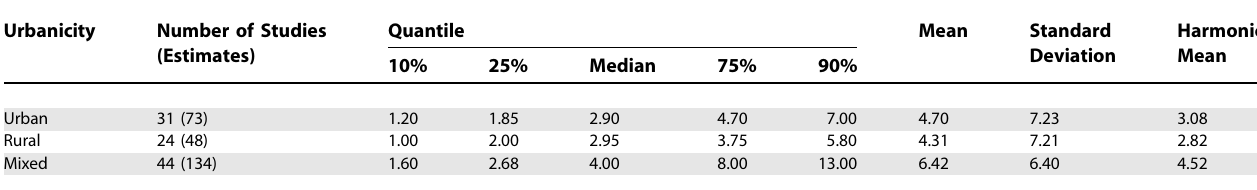
Table 9. Quantiles and Moments of Combined Prevalence Estimates per 1,000 for Persons by Urbanicity